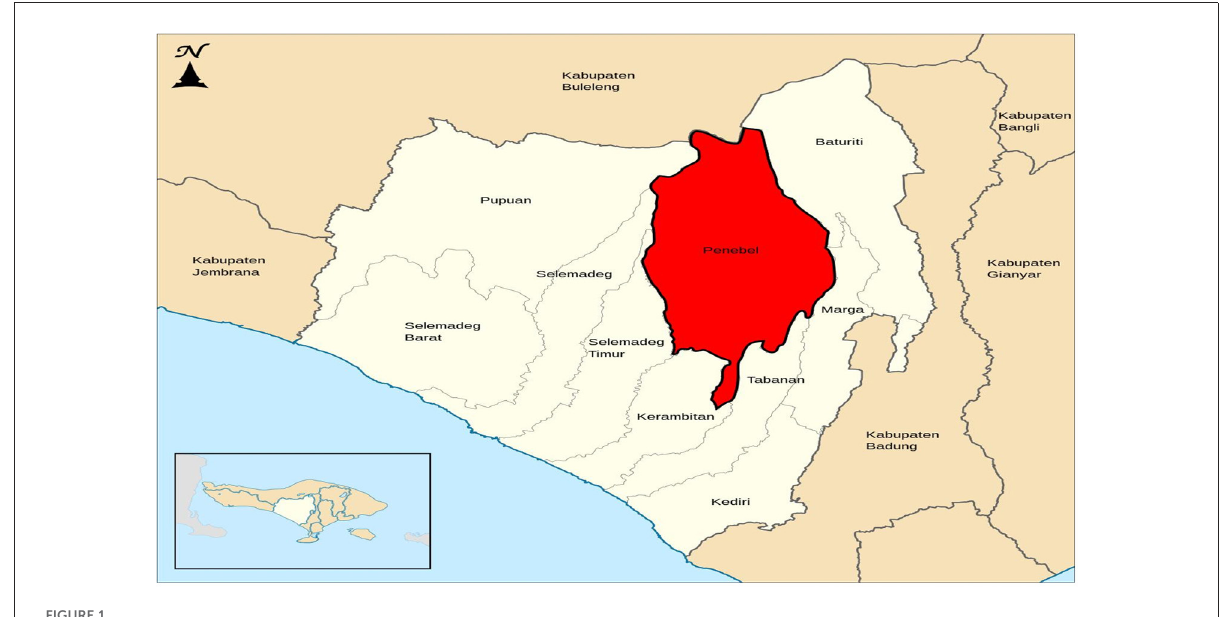
FIGURE1 Map of research location (red